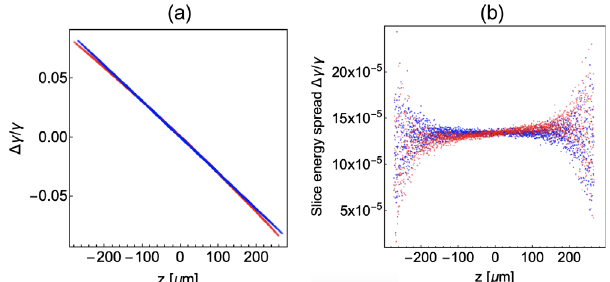
FIG. 7. Longitudinal phase space (a) and slice energy spread (b) at the exit of the TCBC at 250 MeV with tuned voltage Δ V ¼ þ 26 . 5 kV in the last TCAV and the optimized Twiss parameters of β x;y ¼ 150 m and α x;y ¼ − 1 . 3 in the linear (blue line) and nonlinear (red line)